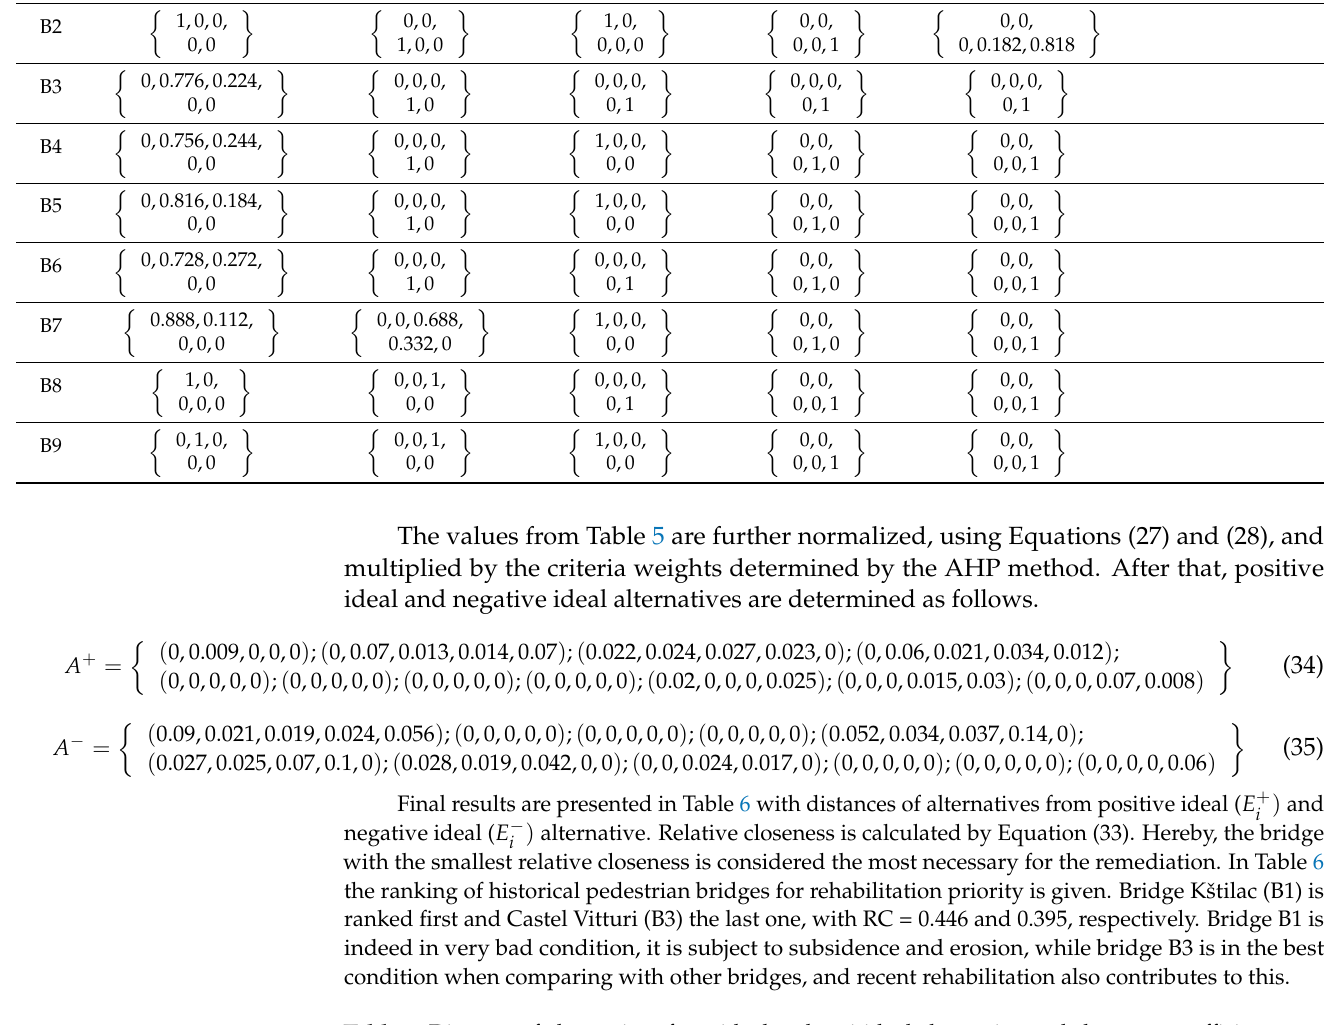
Table 6. Distance of alternatives from ideal and anti-ideal alternative and closeness